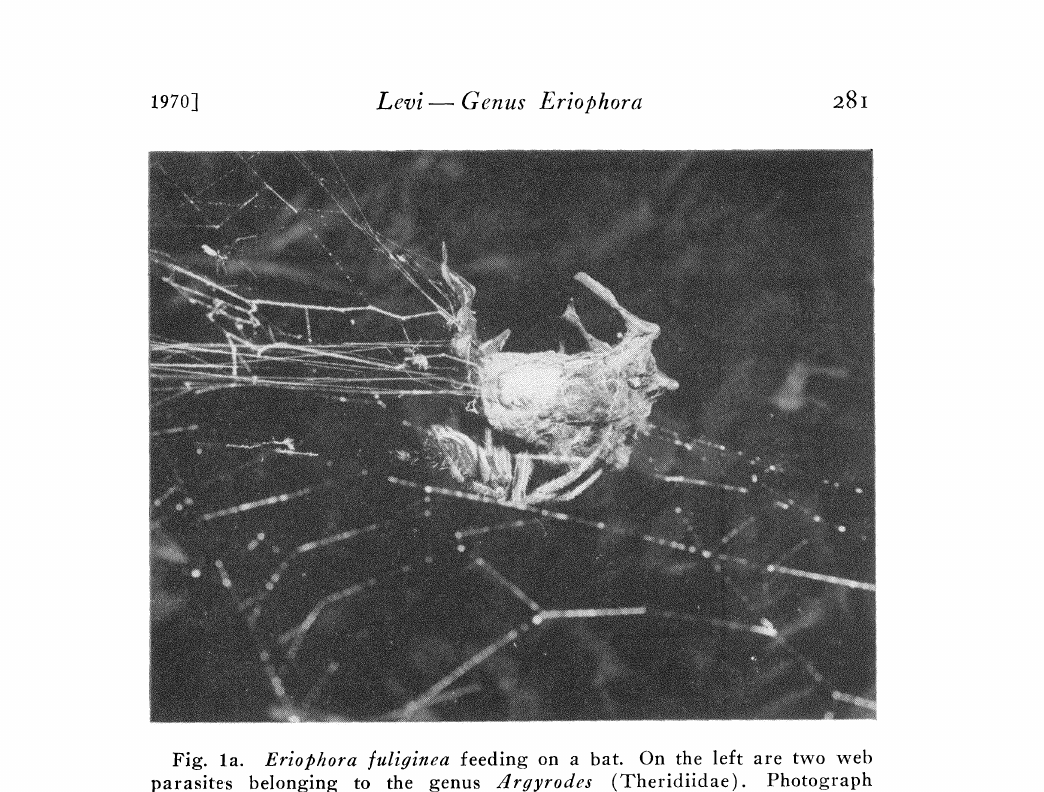
Fig. la. Eriophora fulitTinea feeding on a bat. On the left are two web parasites belonging to the genus ArTyrodes (Theridiidae). Photograph taken in the Panama Canal Zone by Dr. R.